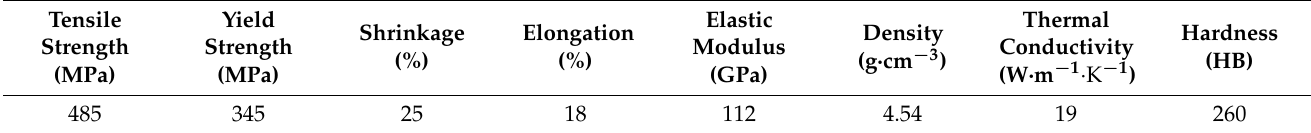
Table 2. Mechanical properties of the TA10.